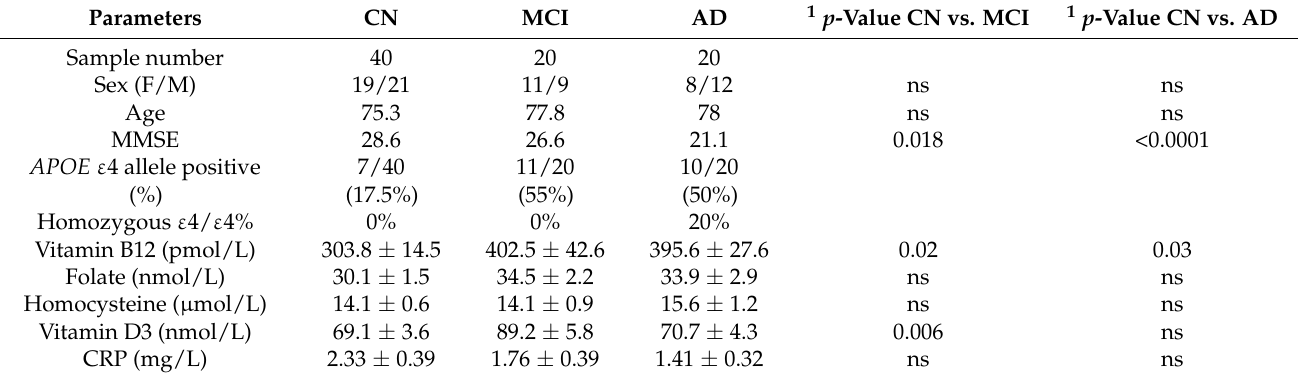
Table 1. Age and gender, MMSE scores and various blood measurements between